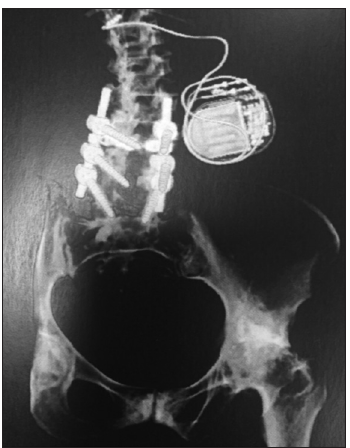
FIGURE 6. A patient diagnosed with chronic FBSS after lumbar arthrodesis underwent spinal cord stimulation implantation. The intraoperative radiography, at the coronal section, shows the dis- placement of the implanted electrode.